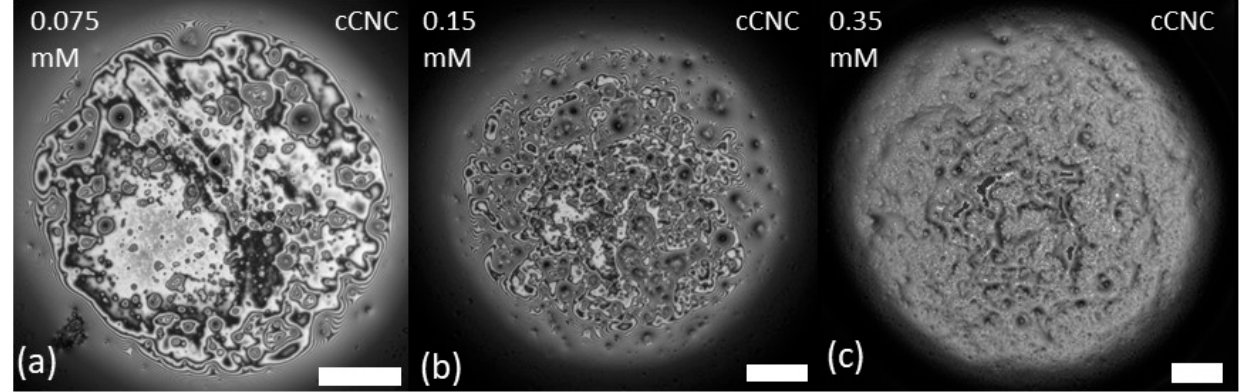
Figure 4. Morphology of LAE ‐ cCNC films after the pressure step of 100 Pa at the end of the drainage. ( a ) CNC ‐ LAE 0.075 mM; ( b ) CNC ‐ LAE 0.15 mM; ( c ) CNC ‐ LAE 0.35 mM. Cellulose nanocrystal concentration, 0.3 wt%. Scale bar is 100 µ m.